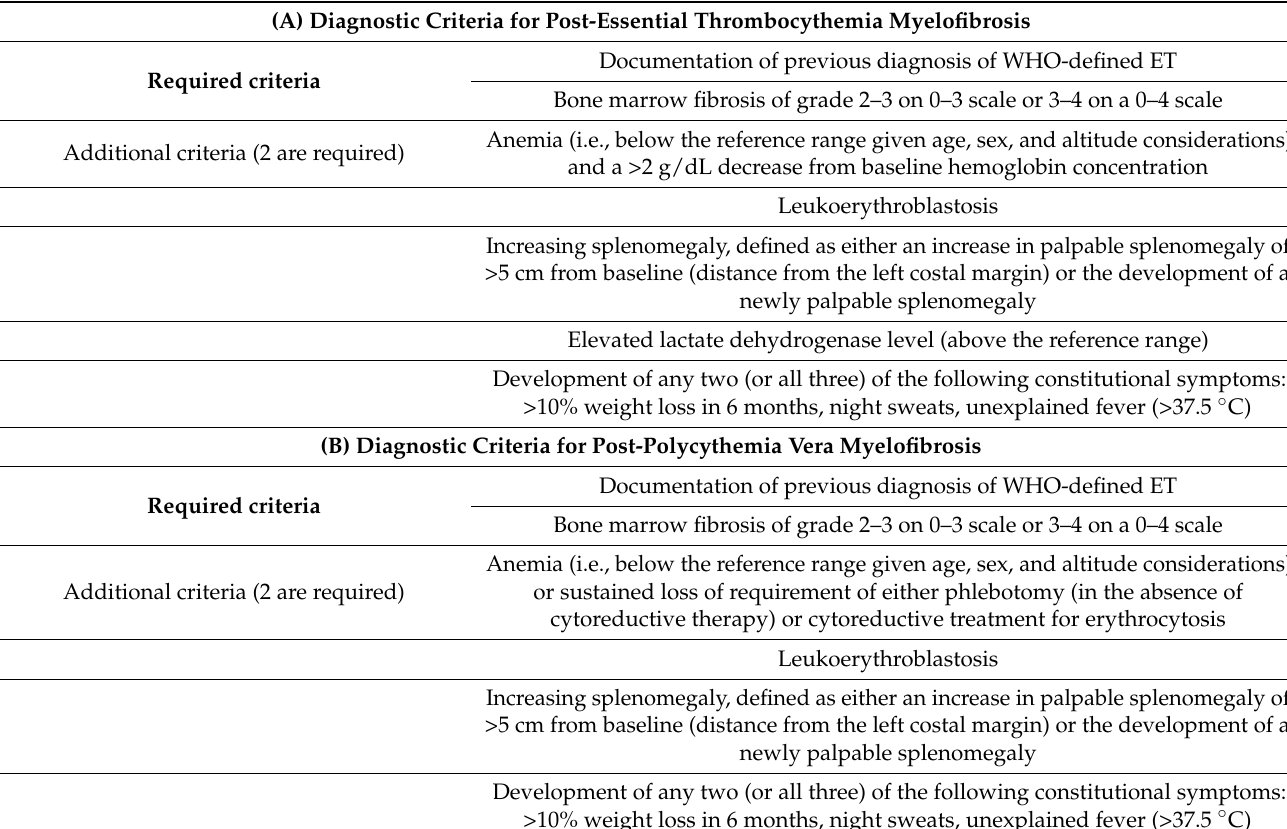
Table 1. WHO (revised 4th edition) classification diagnostic criteria for post-ET ( A ) and post-PV MF ( B ). (A) Diagnostic Criteria for Post-Essential Thrombocythemia